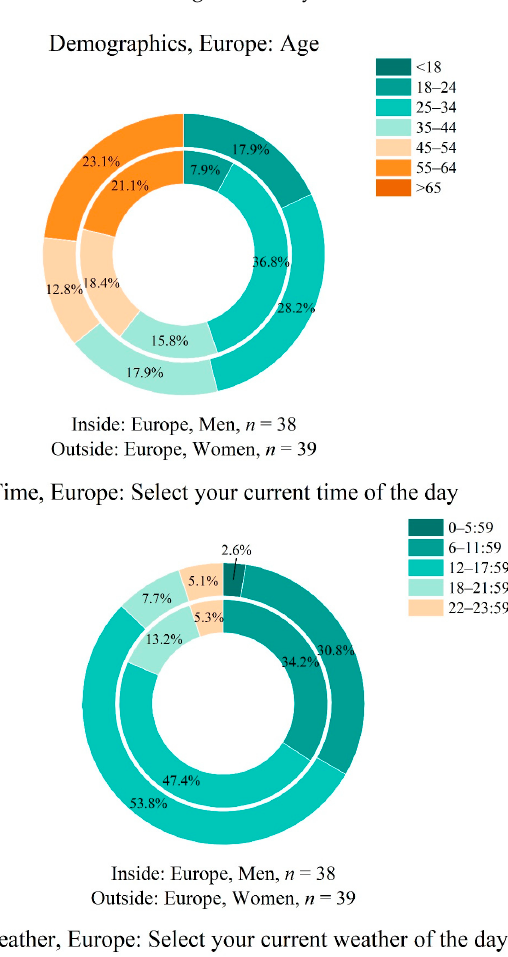
Table 5. Age, participated time and weather condition during the survey.